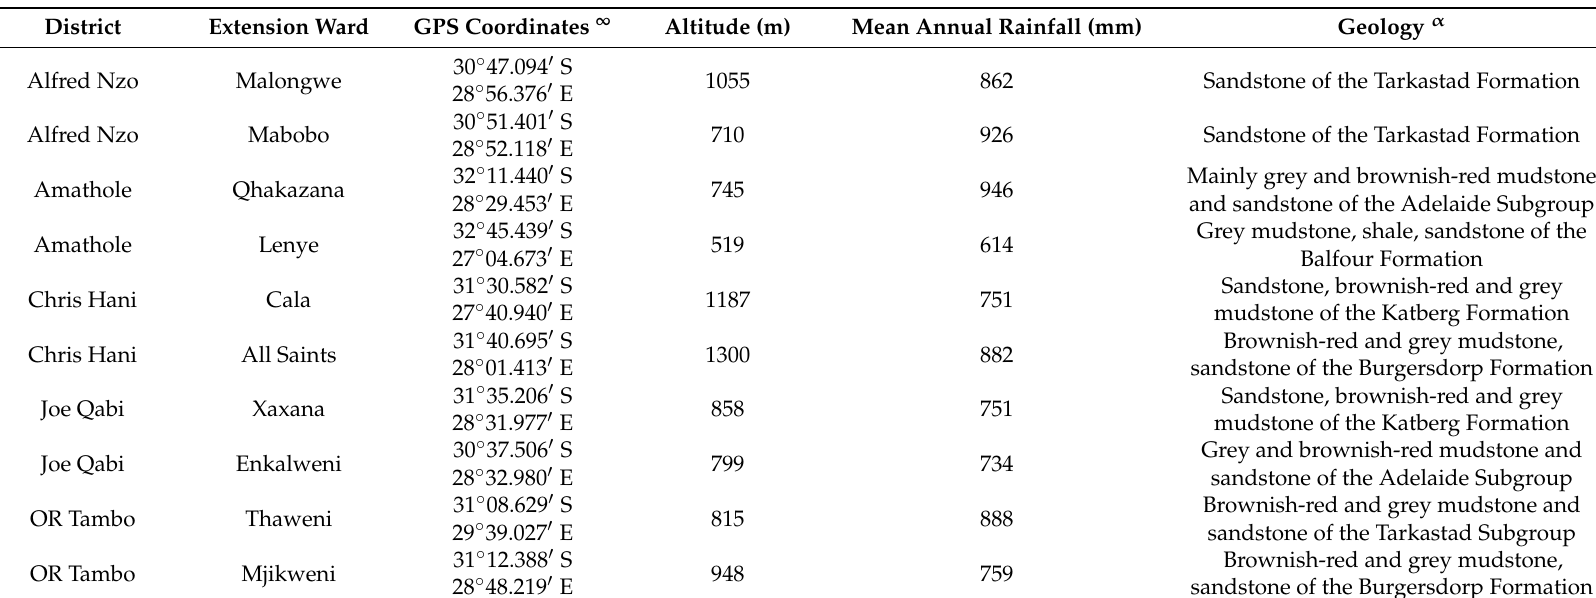
Table 1. Geographical location, altitude, annual rainfall and geology of the extension wards for the conservation agriculture study in the Eastern Cape Province.